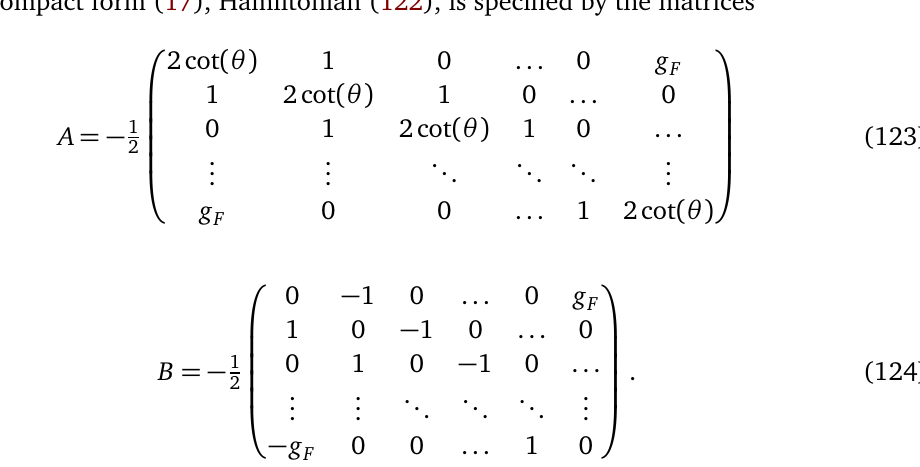
Table 1: Corrspondences between spin models and fermionic models. In the case of periodic and antiperiodic boundary conditions of the TFI, the boundary conditions of the fermionic model depend both on the boundary condition of the spin model and on the parity of the number of particles in the chain. In the case of open boundary conditions of the TFI, the boundary condition of the associated fermionic model are independent from the the number of particles in the chain. = − 1, (f.q.h. antiperiodic) Even sector g = 1 (TFI periodic) F g = + 1, (f.q.h periodic) I Odd Sector g F = 0 (TFI open) Even / Odd sector g = 0, (f.q.h. open) g I F = + 1, (f.q.h. periodic) Even sector g = − 1 (TFI antiperiodic) F g = − 1, (f.q.h I Odd Sector g F